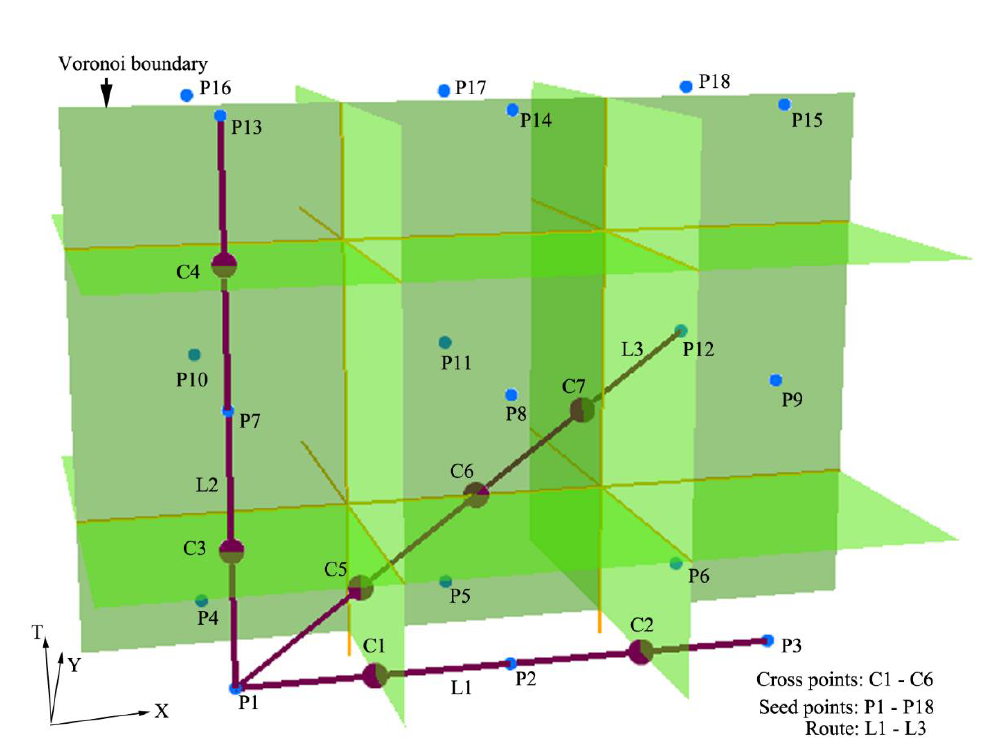
Figure 1. Spatial-temporal representation of VRPTW.